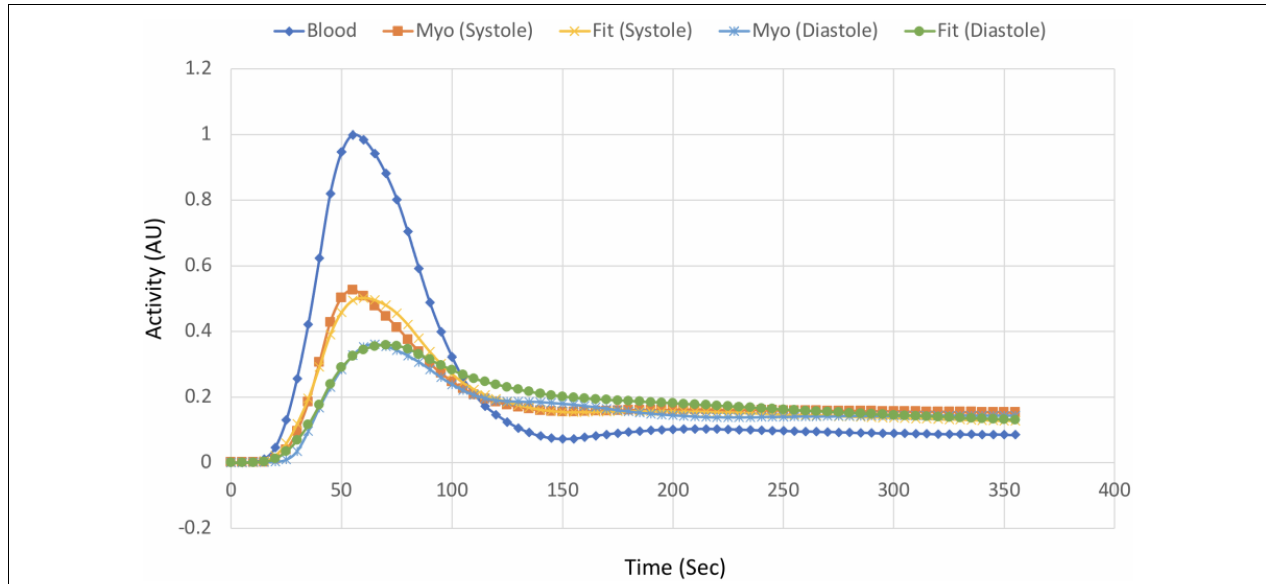
FIGURE 16 | TACs of the myocardium at systole and diastole phase and corresponding fits along with the input function (LV blood pool) for Case 1 study. The data was fitted with the 1TCM for the simulation using LV blood pool as an input function.